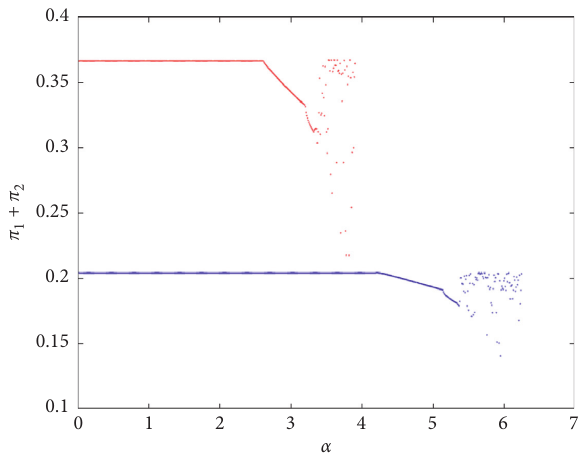
Figure 10: The total profit of